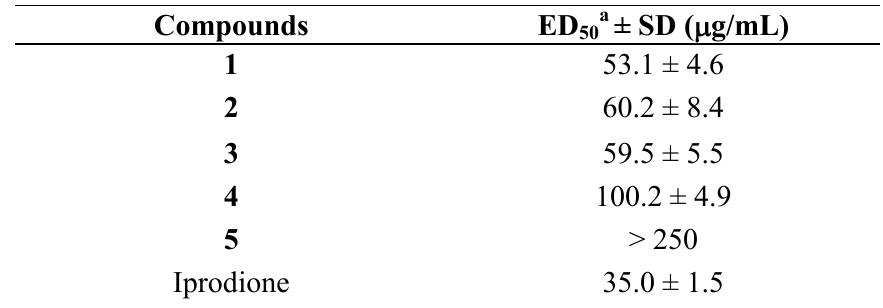
Table 2. Effect of salvic acid, acetylsalvic acid and their hemisynthetic derivates on in vitro mycelial growth of B. cinerea